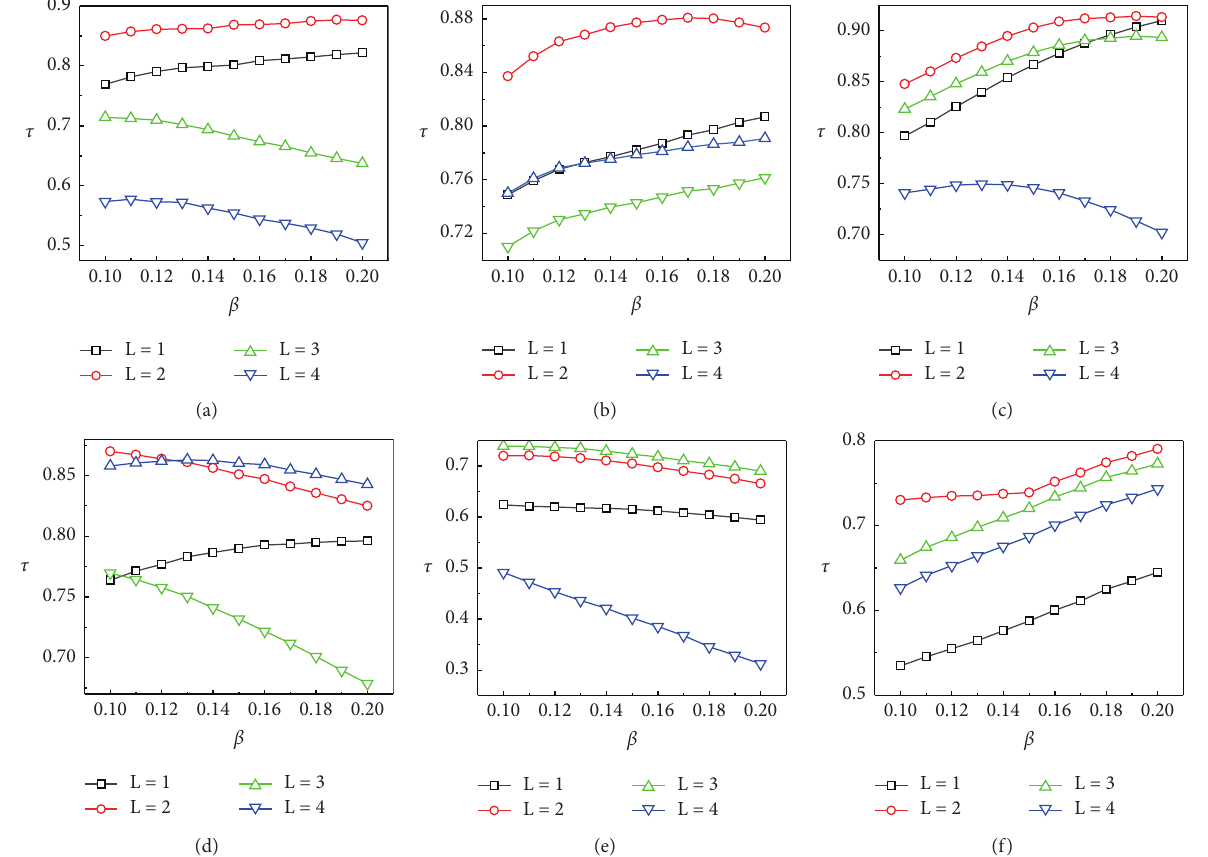
Figure 3: (Color online) The figure shows the effect of parameter L on Kendall’s Tau τ calculated by the IIE method in six networks. The larger value of Kendall’s Tau indicates that the IIE method performs best along with the parameter L . We set β ∈ [ 0 . 1 , 0 . 2 ] and μ � 1. Each data point is calculated from the average of 10 3 experiments. (a) US air. (b) Polblogs. (c) E-mail. (d) Soc-hamsterster. (e) Facebook. (f)